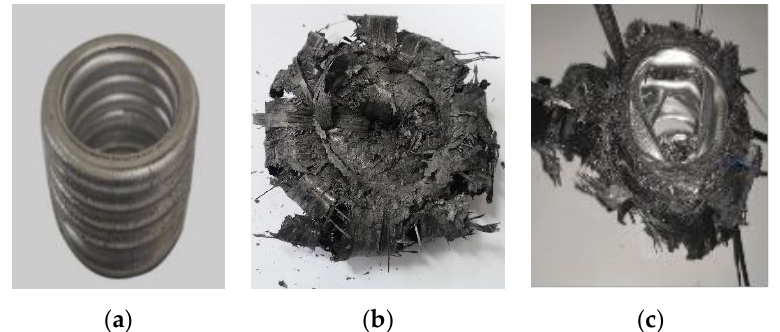
Figure 4. Failure modes of three types of circular tubes after quasi-static crushing tests: ( a ) Al tubes; ( b ) CFRP tubes; ( c ) CFRP-Al tubes.